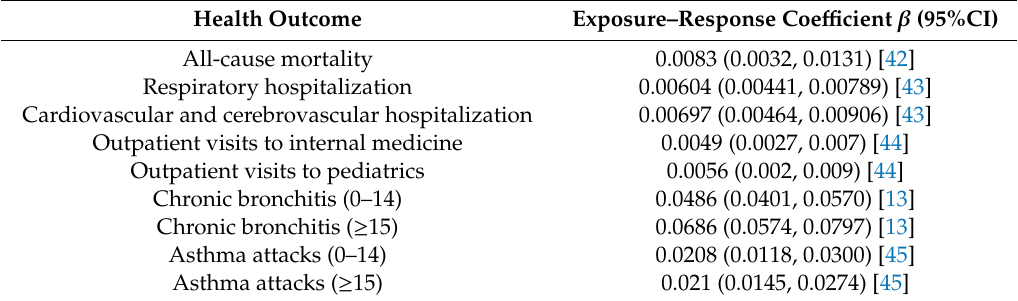
Table 1. Exposure-response coe ffi cients of fine particulate matter (PM 2.5 ) related health e ff ects.